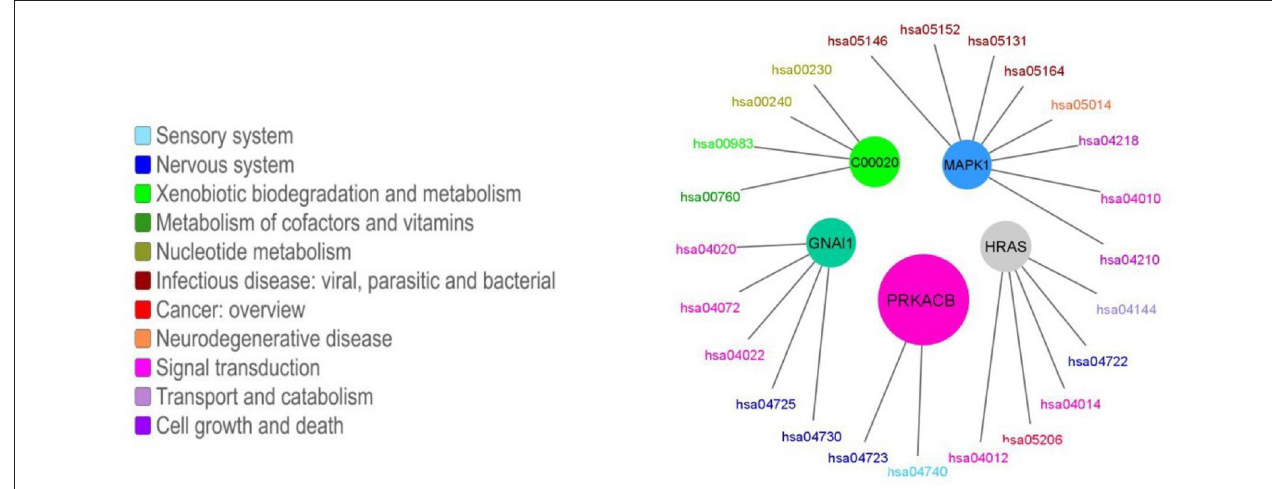
FIGURE 6 | Enriched pathways for the five biggest modules. The colored circles represent each of the five biggest modules. The size of the circle is proportional to the number of nodes in each module. Each module is connected to its enriched pathways. The color of the pathways is related with their function, which was taken from KEGG’s functional classification. Different tones of blue are associated with organismal systems, different tones of green are associated with metabolic pathways, different tones of red and orange are associated with human diseases, different tones of pink and purple represents the broad functional category of environmental information processing. Each module is named as one of the molecules it